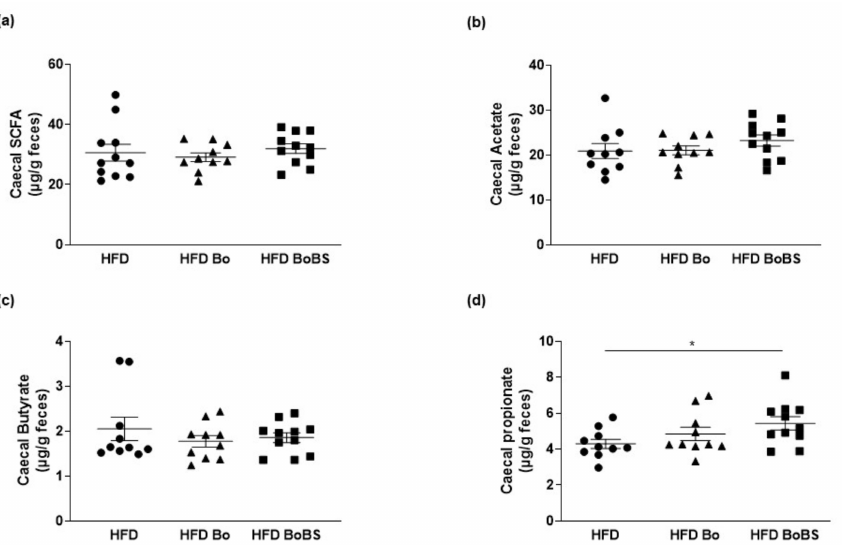
Figure 5. Cecal short chain fatty acids (SCFA) analysis and quantification in ApoE − / − mice. Total cecal SCFA ( a ), acetate ( b ), butyrate ( c ), propionate ( d ) content in mice receiving HFD (black circle, n = 11; samples from 11 males) or HFD containing Bolero under standard condition (Bo, black triangle, n = 10; samples from 10 males) or Bolero under biotic stress condition (BoBS, black square, n = 11; samples from 11 males) throughout the 14 weeks of diet. Data were given as mean ± SEM. * p < 0.05 vs., HFD group.